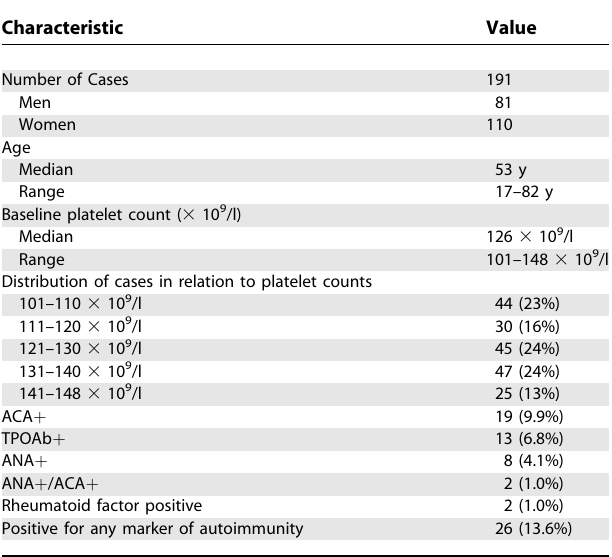
Table 3. Characteristics of Individuals with Borderline Throm- bocytopenia Who Began Follow-Up Characteristic